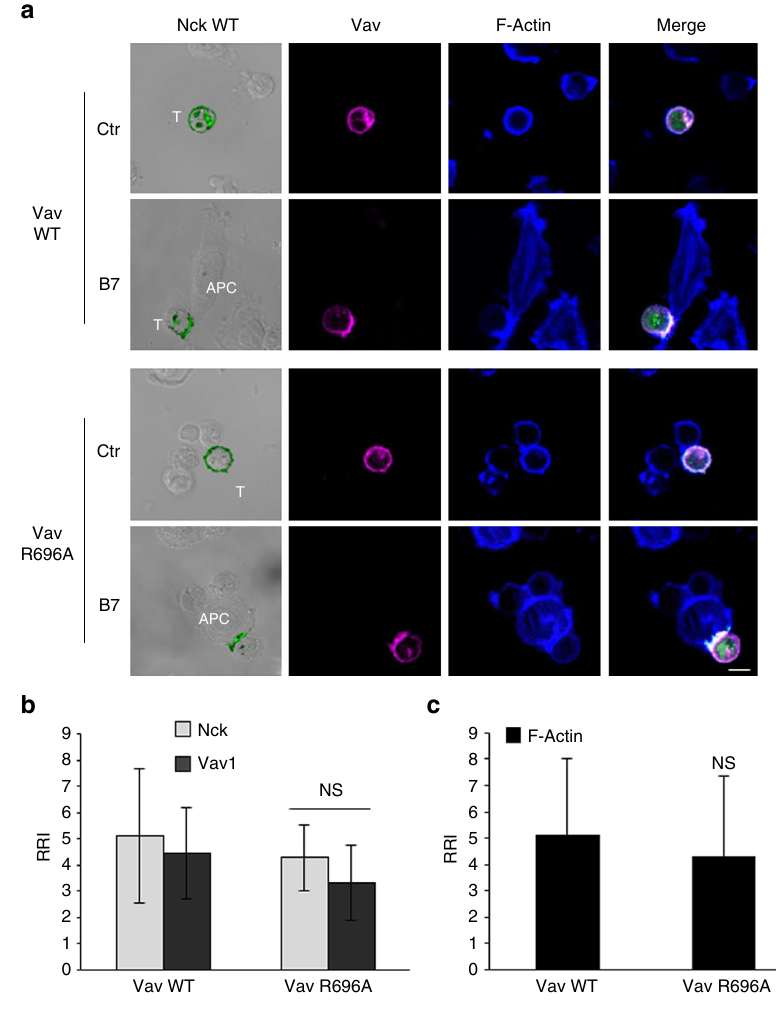
Fig. 9 Vav SH2 domain is not required for Nck recruitment to CD28 and actin rearrangement and polarisation. a Human CD28WT cells were transfected with pm-Cherry Vav1 WT or Vav R696A mutant (magenta) together with GFP-Nck WT (green) and then stimulated for 15 min in the absence (Ctr) or presence of Dap3/B7 cells (B7). After fi xing and permeabilisation F-actin was stained with 633-conjugated phalloidin (blue) and analysed by confocal microscopy. The scale bar represents 10 μ m. The frequency of conjugates (total 15) showing signi fi cant (RRI > 2.5) Vav1 and Nck recruitments ( b , c ) or F- actin polarisation ( c ) were calculated and data represent the mean ± SD of three independent experiments. Mean values: Vav WT, Nck = 5.1 ± 2.5, Vav = 4.4 ± 1.7, F-actin = 7.1 ± 2.9; Vav R696A, Nck = 4.3 ± 1.2, Vav = 3.3 ± 1.4, F-actin = 6.7 ± 3.1. NS not signi fi